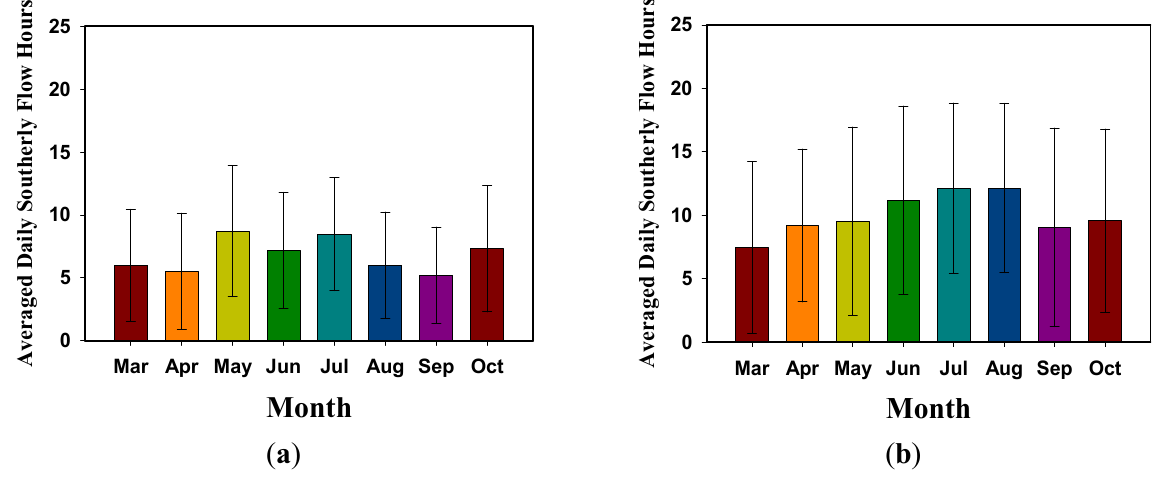
Figure 7. Daily southerly flow hours at Aldine during 1995–1996 ( a ) and 2010–2011 ( b ).